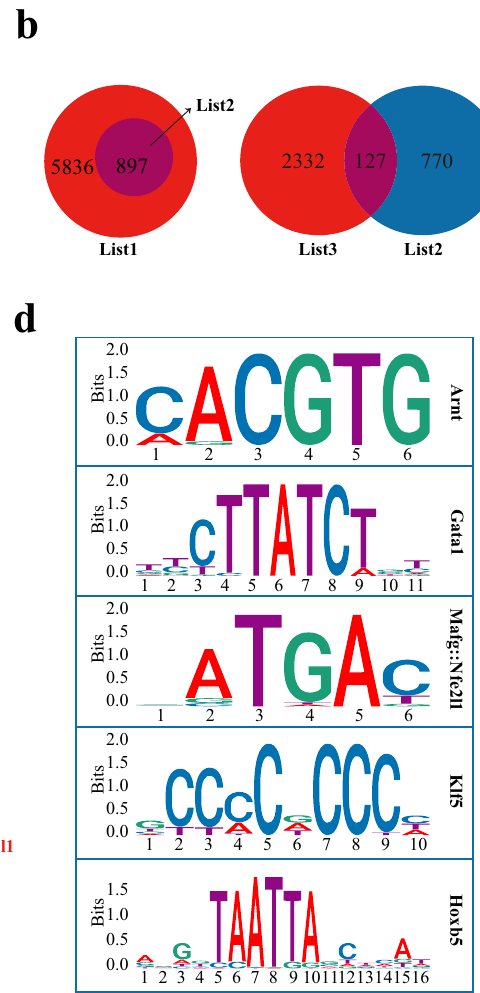
247.17±25.96,236.83±79.19,198.83±23.64and166.33±27.20insixtissues. b The venndiagramsofthreegenelists.List1:Genelistannotatedwithhigh-FSTSVs.List2: Genelist annotated with high-FST SVs located in exon and promoter. List3: Differ- entially expressed genes between domestic yak and taurine cattle in lungs. c The motif enrichment results ofpeaklocatedin the promoter with high-FSTSVs. The p valueswerecalculatedusingFisher ’ sexacttest. d Thesequenceinformationof fi ve special motifs. Source data are provided as a Source Data fi